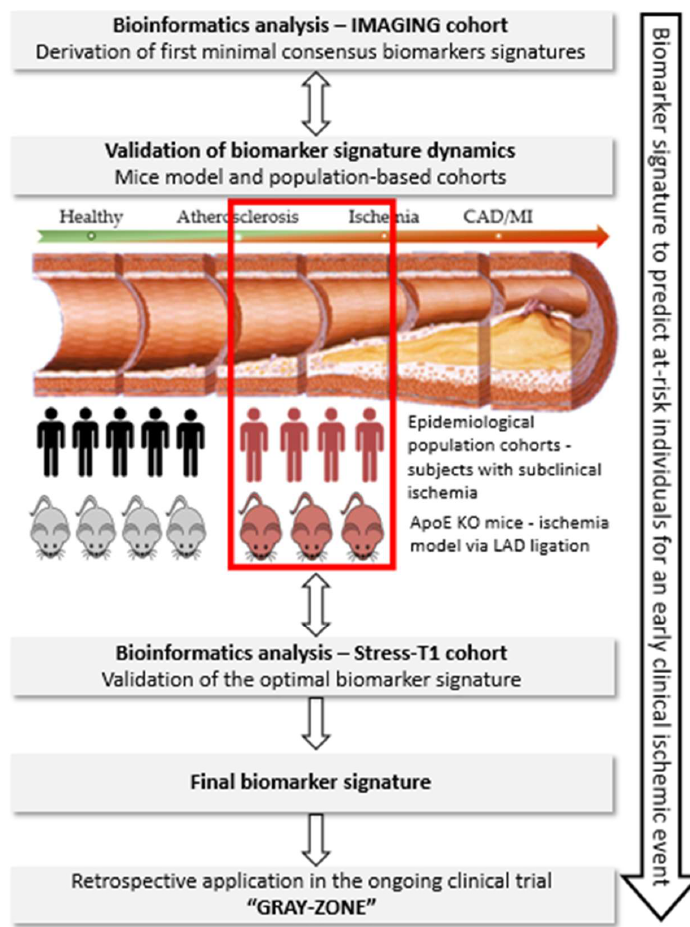
Figure 1. Schematic presentation of the methodology that will be followed to achieve the optimal biomarker signature in the PREMED-CAD consortium. Target disease population: the subclinical disease stage, immediately ( < 12 months) before the occurrence of coronary events will be studied. Work-flow of experiments: through bioinformatics tools and validation in murine models and epidemiological cohorts, the biomarker signature for subclinical ischemia in CAD will be identified and validated in the ongoing clinical trial GRAY-ZONE.